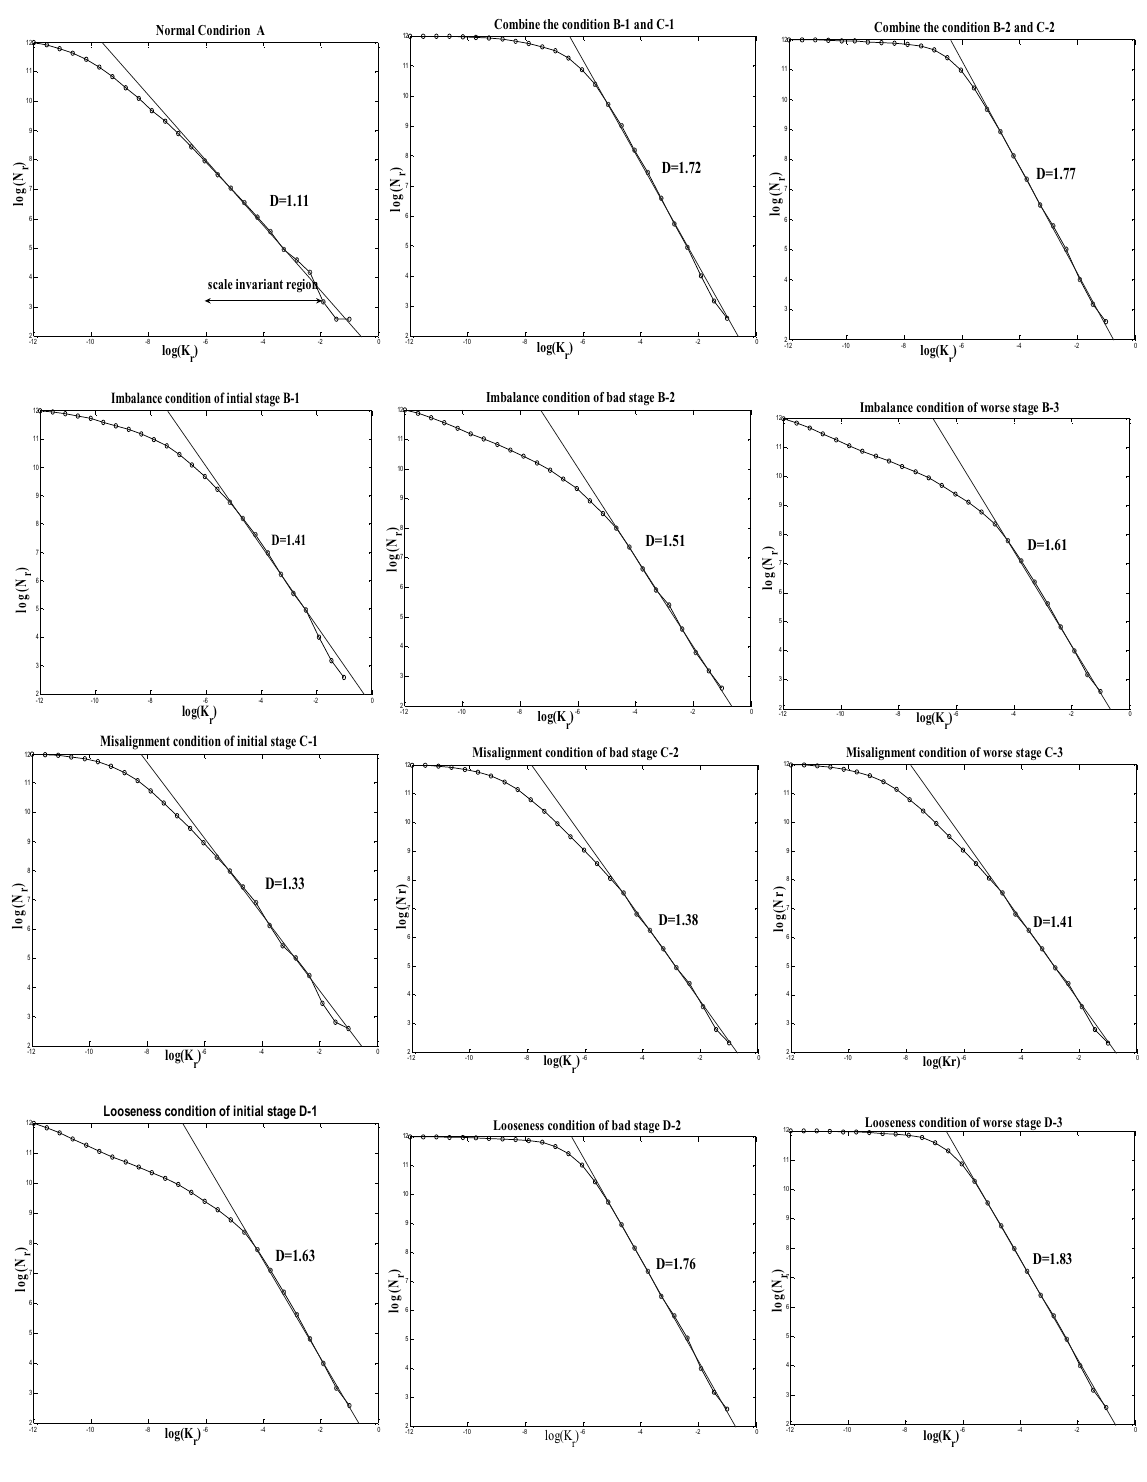
Fig. 9. The fractal logarithm curves of different fault